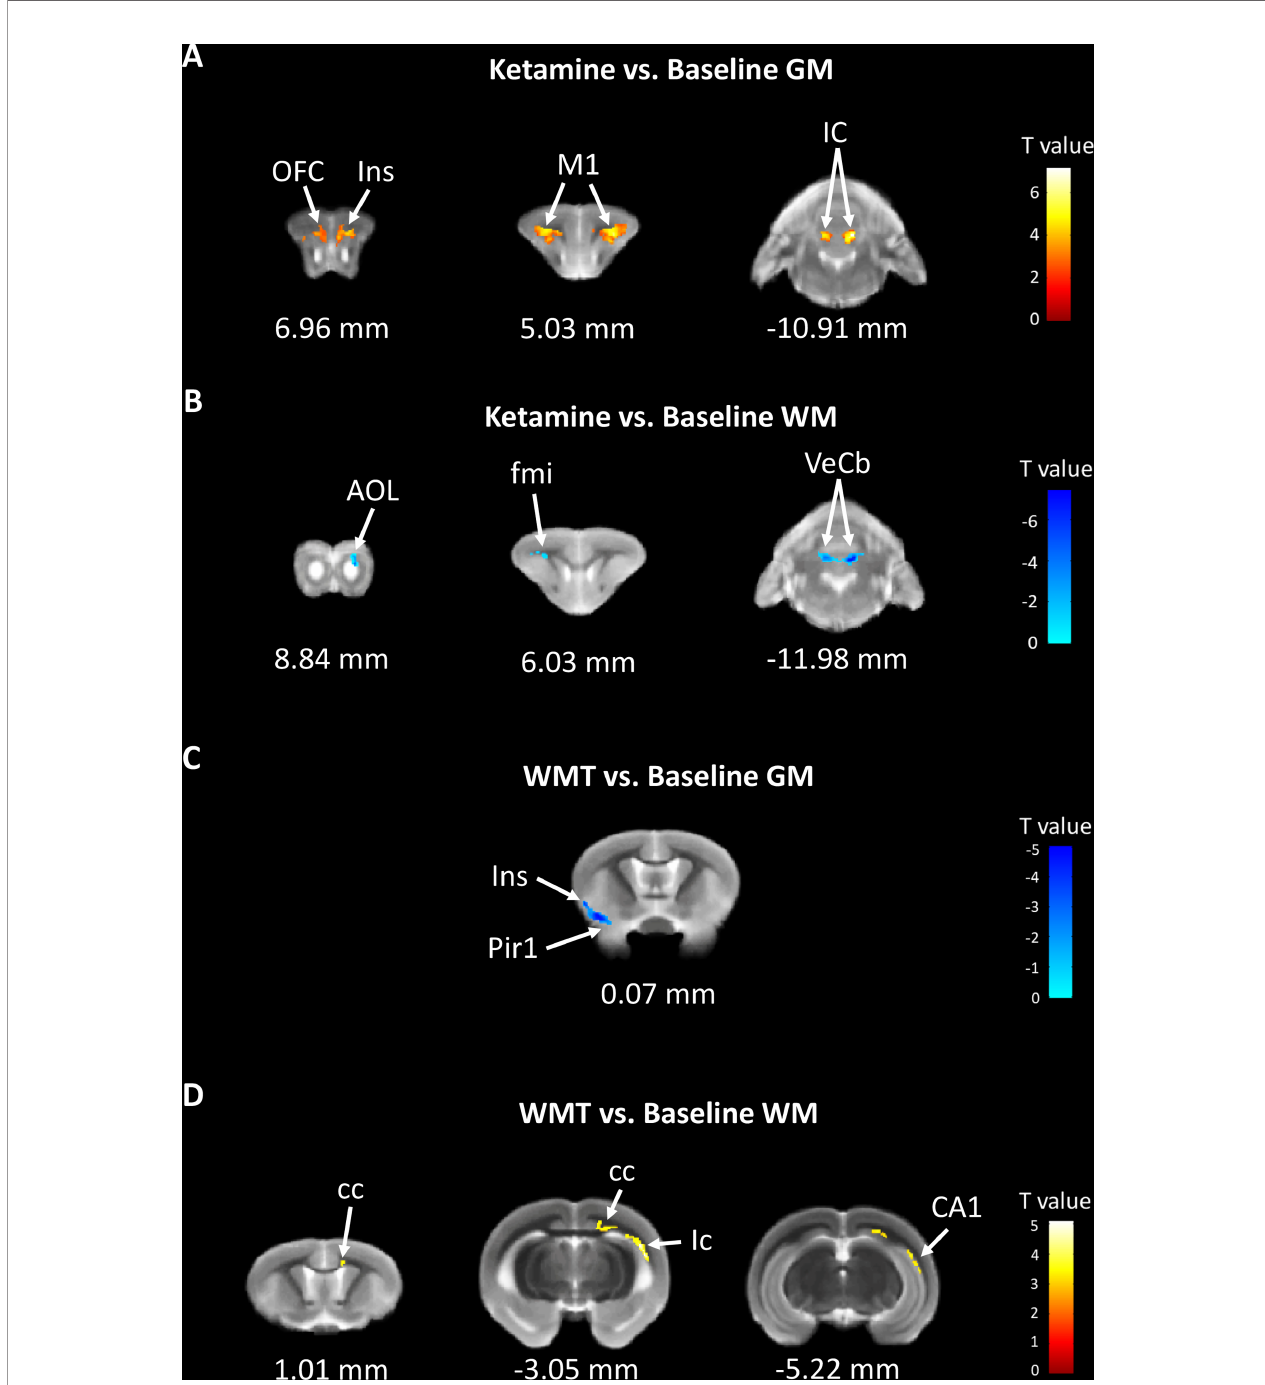
FIGURE 5 | The changes in brain structure showed the recovery effect of WMT but potential addiction effect of ketamine. (A) The GM density signals from OFC (orbital frontal cortex), Ins (insular cortex), M1 (primary motor cortex) and IC (inferior colliculus) were increased, but (B) the WM density signals from AOL (anterior olfactory nucleus, lateral part), fmi (forceps minor of the corpus callosum) and VeCb (vestibulocerebellar nucleus) were decreased after ketamine administration. (C) The GM density signals from Ins and Pir1 (piriform cortex, layer 1) were decreased, but (D) the WM density signals from cc (corpus callosum), ic (internal capsule) and CA1 ( fi eld CA1 of the hippocampus) were increased after WMT. N =